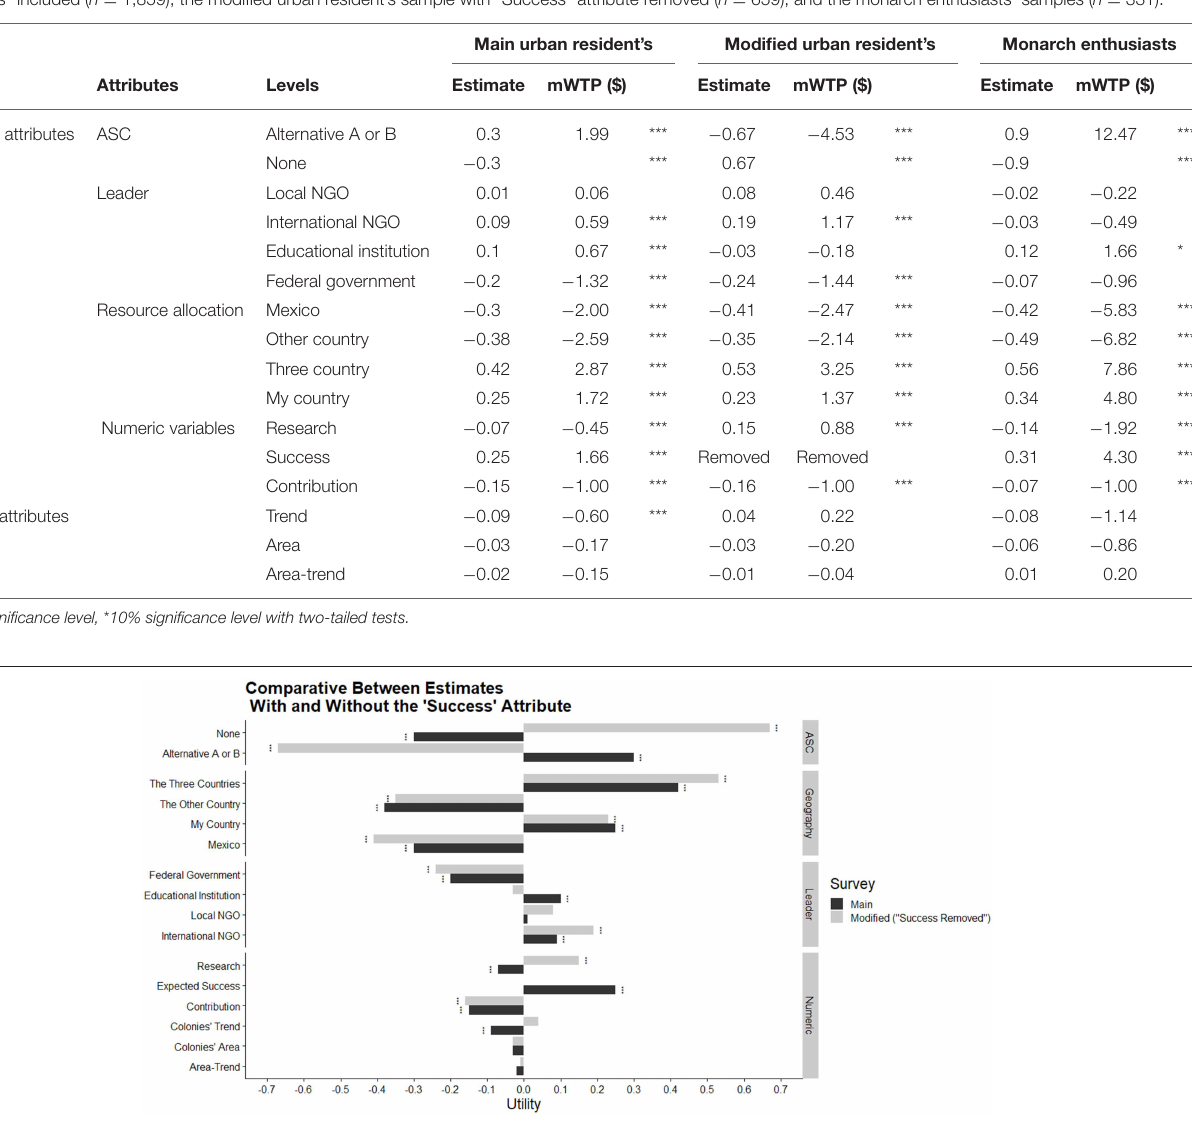
FIGURE 4 | Change in utility estimates for the MNL (one-class model) of the main urban resident and the modified urban resident (with “Success” attribute removed) samples. The x-axis is a dimensionless representation of the utility derived from a specific level of an attribute. ***1% significance level with two-tailed